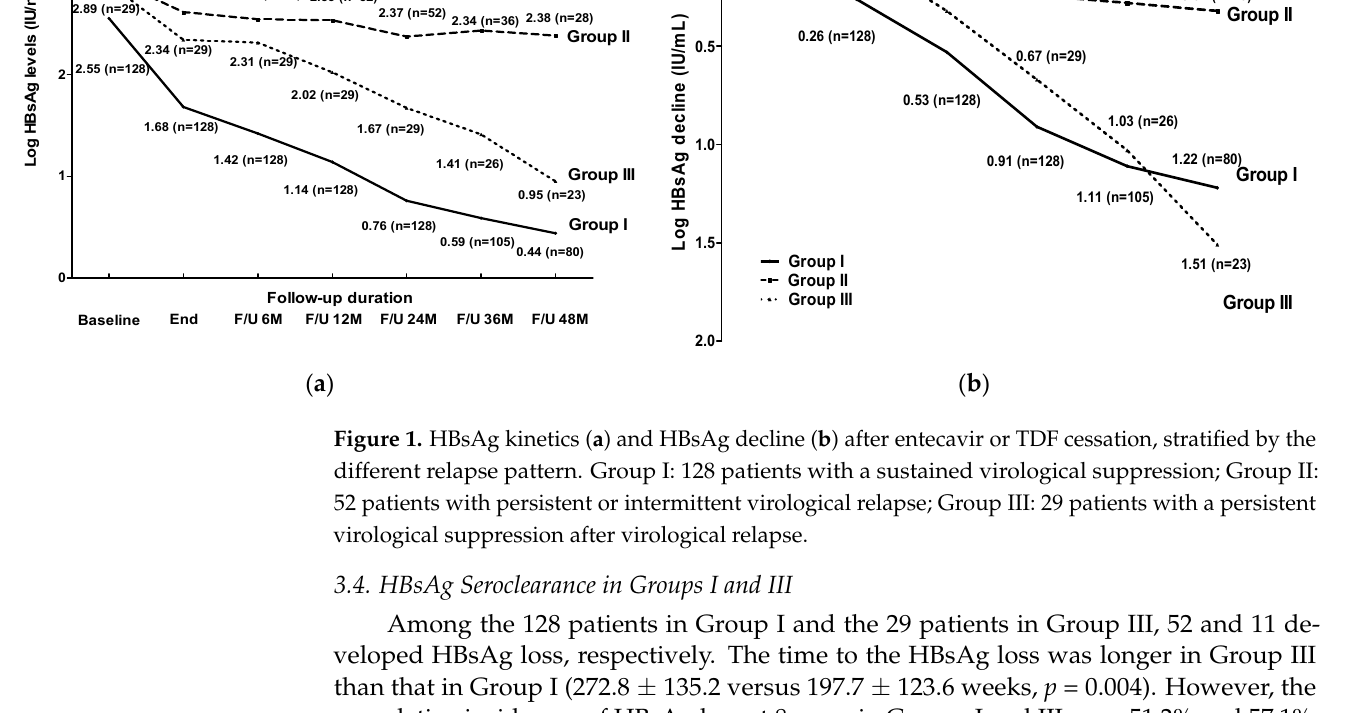
Table 5. Factors associated with HBsAg loss in the patients of Groups I and III.